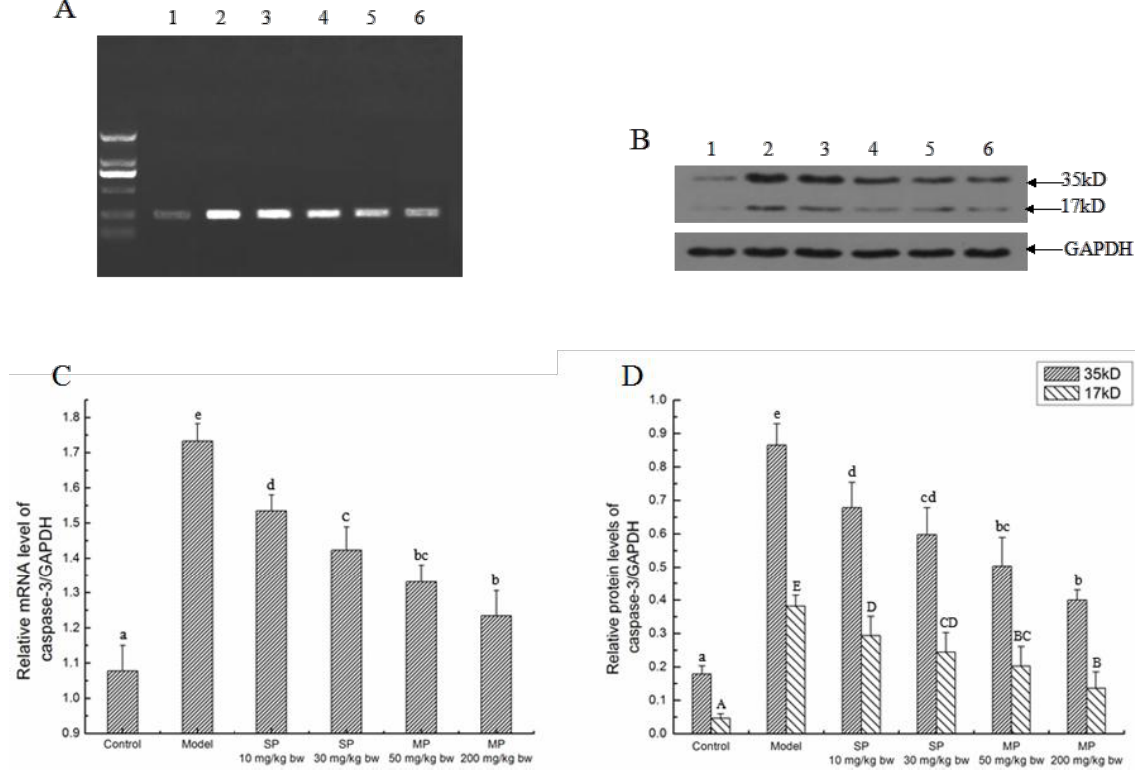
Figure 7. The relative mRNA and protein expressions of caspase-3 in each group. Representative ( A ) electrophoregram and ( B ) western blots for caspase-3. GAPDH was used as internal control; ( C ) Relative mRNA level of caspase-3/GAPDH; ( D ) Relative protein levels of caspase-3/GAPDH. Values not sharing a common letter (a, b, c, d, e) in ( C , D ) differ significantly of relative mRNA and protein levels of caspase-3/GAPDH at p < 0.05, separately. Values not sharing a common letter (A, B, C, D, E) in ( D ) differ significantly of relative protein level of cleaved caspase-3/GAPDH at p < 0.05. SP, synthetic pentapeptide; MP, mixed corn peptides. Numbers 1–6 indicate groups